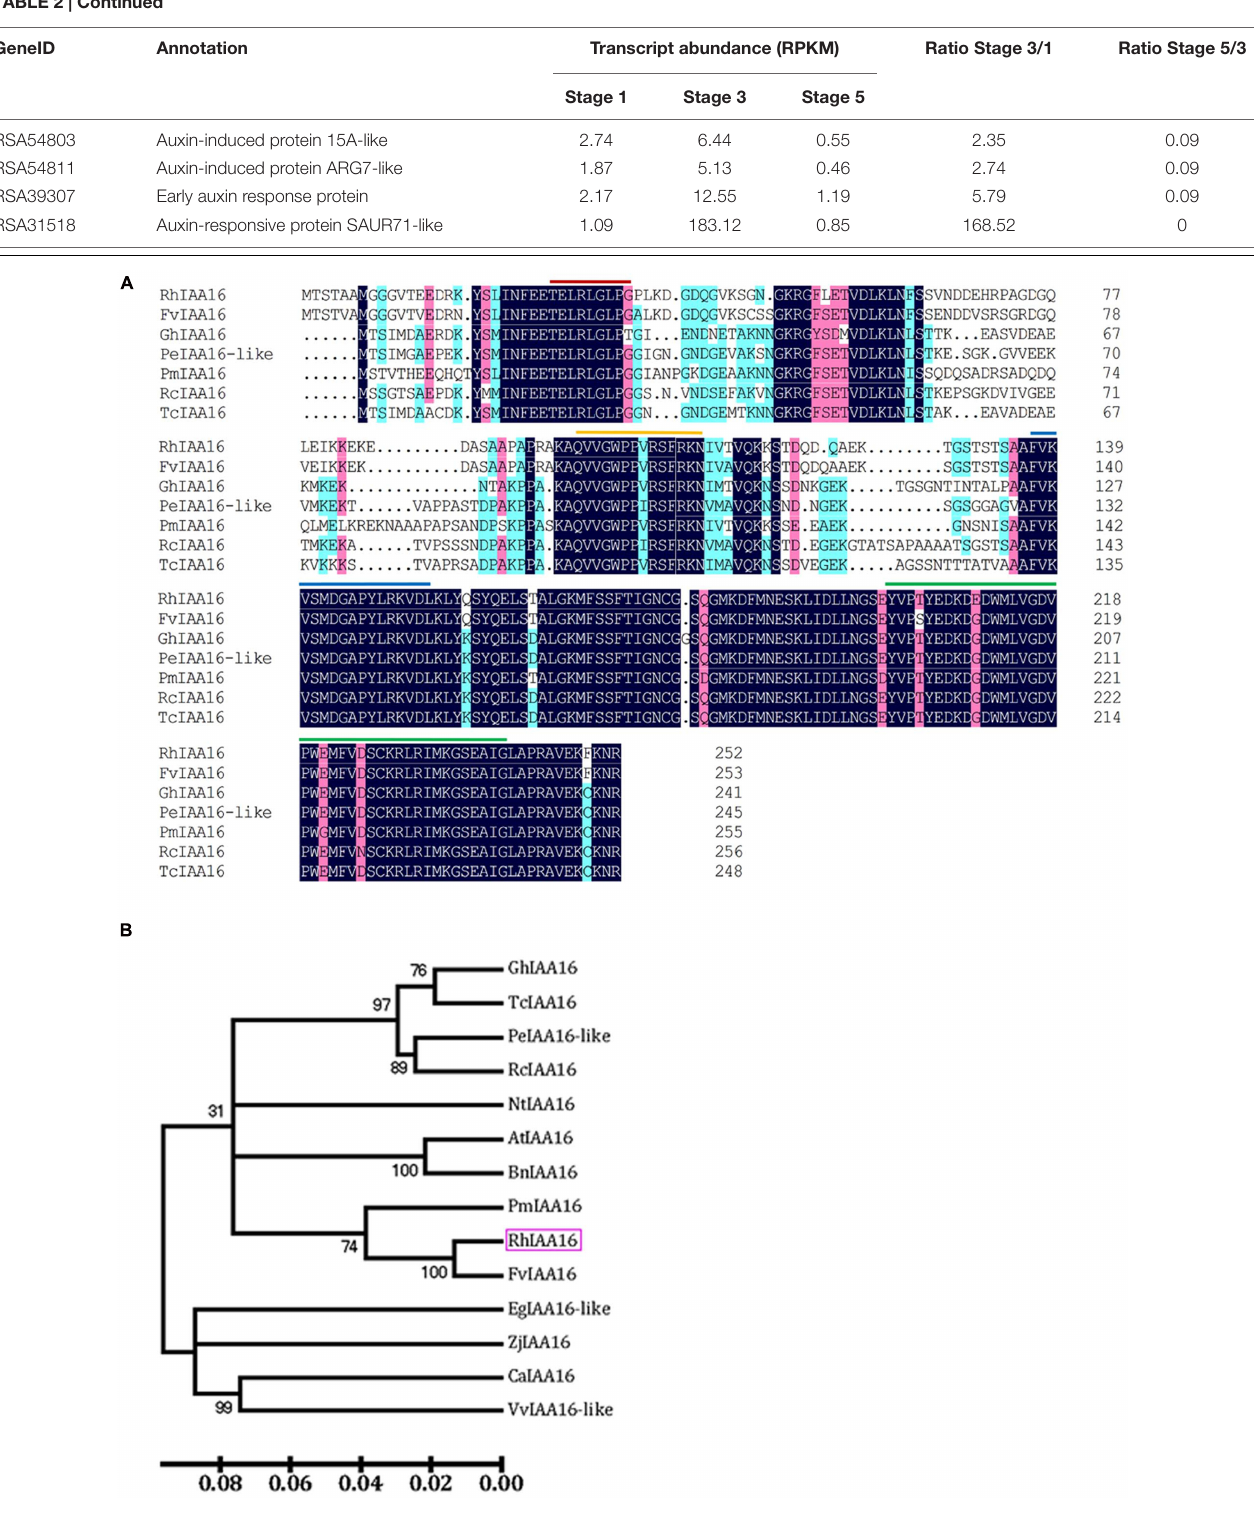
FIGURE 6 | Alignment of deduced amino acid sequences (A) and phylogenetic tree (B) of RhIAA16 protein and representative Aux/IAA members. Lines indicated representatively conserved motif, including red line, domain I; yellow line, domain II; blue line, domain III; green line, domain IV (Audran-Delalande et al.,